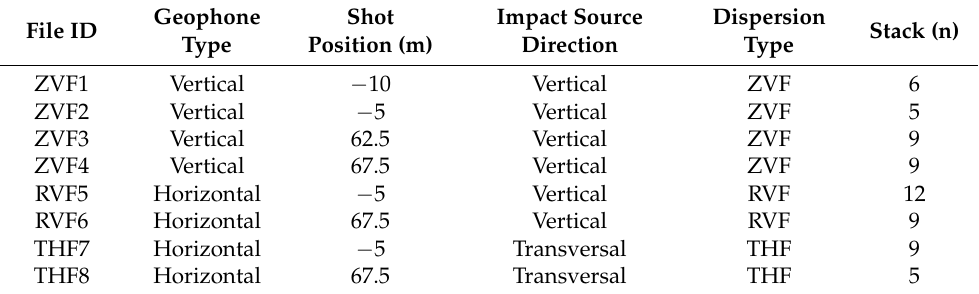
Table 2. Data acquisition parameters (spacing = 2.5 m, sampling rate = 0.00025 s, recording time